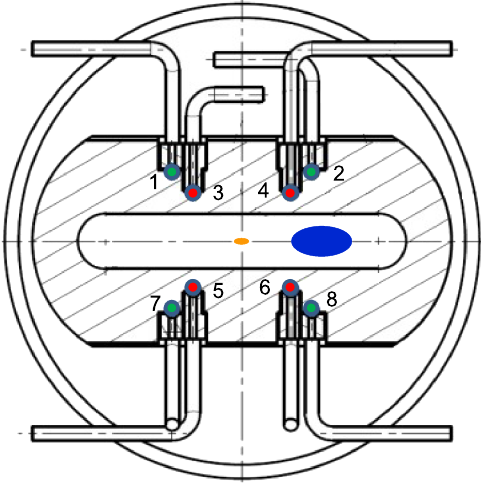
FIG. 6. Front view of the MIK cross section with red and green copper rods numbered from 1 to 8, striped sapphire vacuum chamber (46.8 mm (H) × 7 . 8 mm (V) physical aperture), injected (blue), and stored (orange) beams. The red and green dots on the conductors represent the current direction.